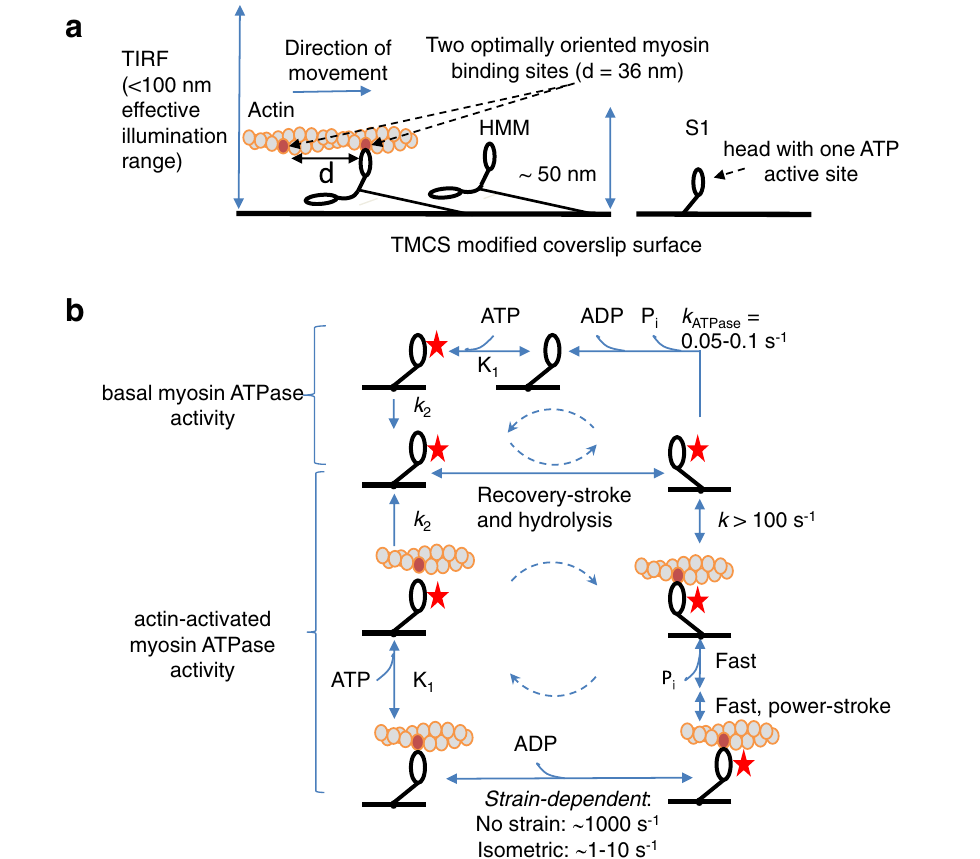
Fig. 1 Schematics of the study assays and major biochemical transitions. a TIRF microscopy assay with depicted major proteins used: actin, heavy meromyosin (HMM), and subfragment 1 (S1) attached to TMCS modi fi ed coverslip surface. Note that the effective evanescence illumination range is comparable to the distance of myosin catalytic site from the surface. b Muscle myosin and actomyosin ATPase cycles. For clarity, only S1 construct is shown. The states with bound nucleotide are marked with a red star. Basal myosin ATPase cycle is rate limited by Pi release, which is signi fi cantly accelerated ( “ activated ” ) by the presence of actin. Dashed circular arrows represent major ATPase cycle